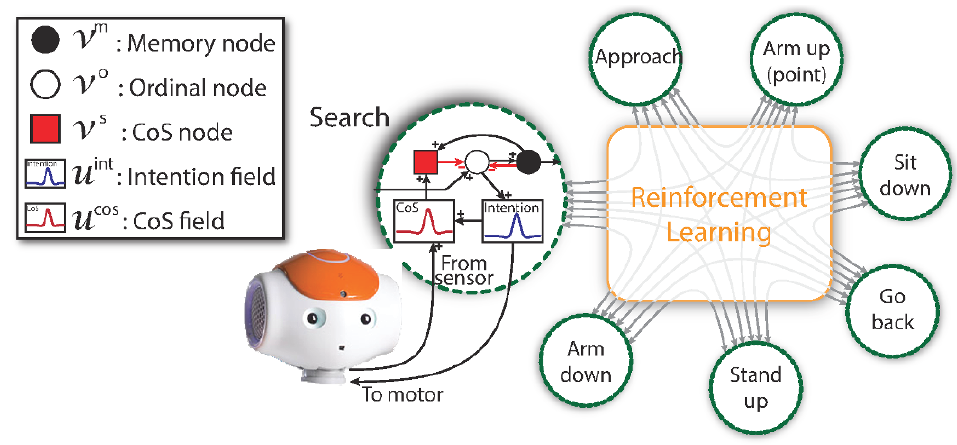
Figure 1. Schematics of the model for sequence generation based on dynamic field theory and reinforcement